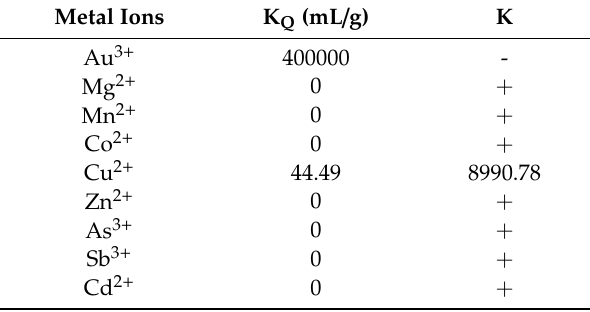
Figure 7. E ff ect of gold adsorption in wastewater. Figure 7. Effect of gold adsorption in wastewater. Table 8. K Q and K of the ions in Table 8. K Q and K of the ions in wastewater.